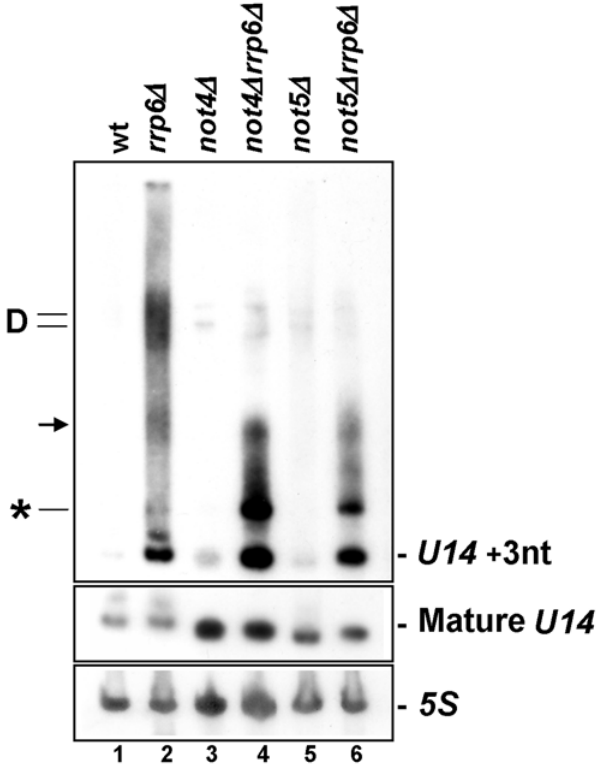
Figure 3. Accumulation of 3 9 -extended and polyadenylated U14 in rrp6 D cells is affected by the Ccr4-Not complex. Total cellular RNA isolated from the indicated strains was analyzed by northern blot first with a probe against 3 9 -extended U14 (upper panel) and then with a probe for mature U14 (middle panel) and a probe for 5S rRNA (lower panel). The position of several extended U14 forms and mature U14 are indicated on each side of the blot (see the text for details). Hybridization against the 5S mature rRNA is shown as a control for loading.